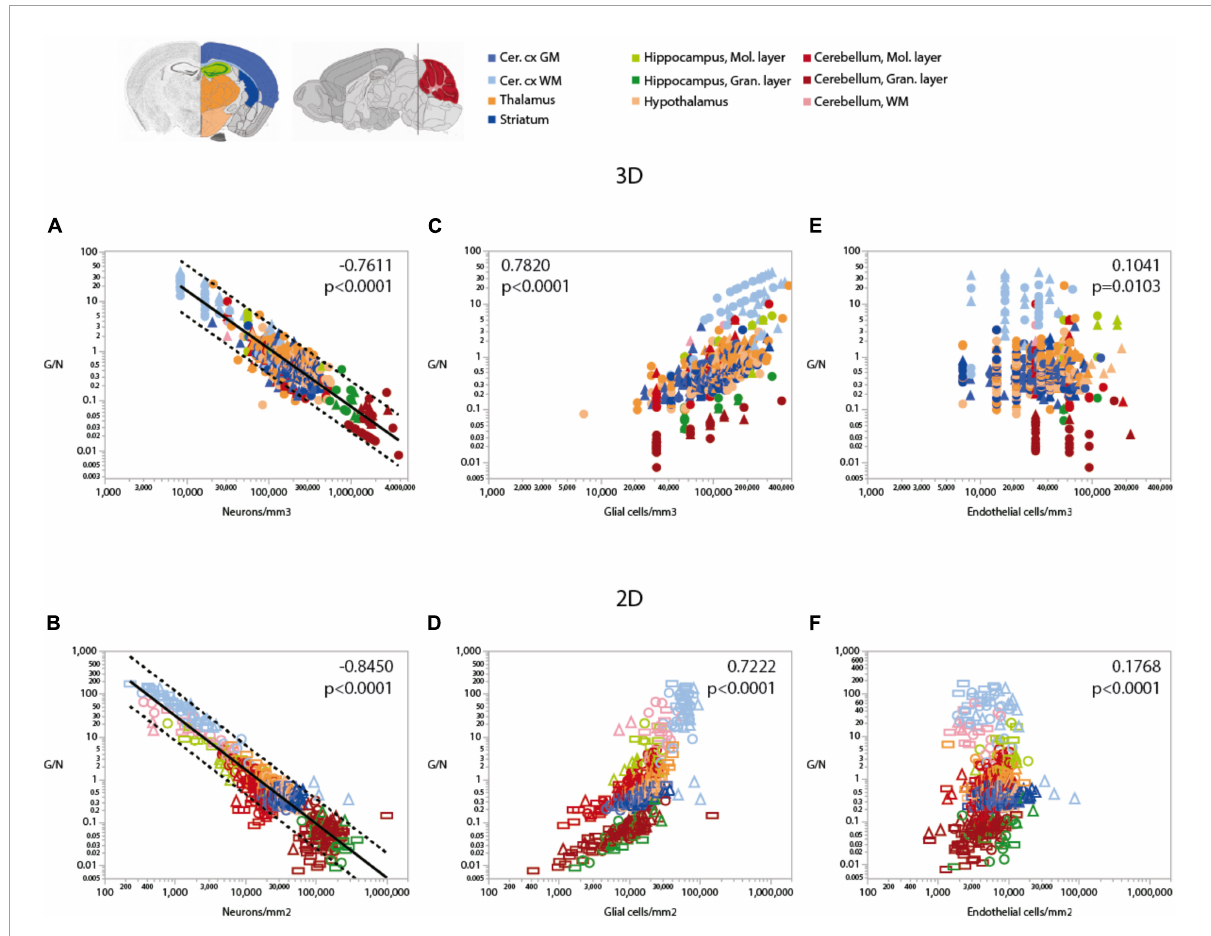
FIGURE6 Ratio of glial cells per neuron (G/N) increases across brain structures and sites with decreasing neuronal densities. Spearman correlation coefficients and p -values across all structures and sites are indicated in each graph; relationships for each structure are given in Table 6 . G/N ratios span over three orders of magnitude and vary as a single power function of neuronal density across all brain structures and sites whether measured in 3D stacks (A) or in 2D composite images (B) . Power functions are plotted with 95% confidence interval (dashed lines), and have exponents –1.162 ± 0.024, r 2 = 0.816, p < 0.0001 ( A , 3D) or –1.257 ± 0.020, r 2 = 0.865, p < 0.0001 ( B , 2D). Notice that most data points in all structures are contained within the 95% CI of the function that applies across structures, indicating that the relationship is brain-wide. (C,D)